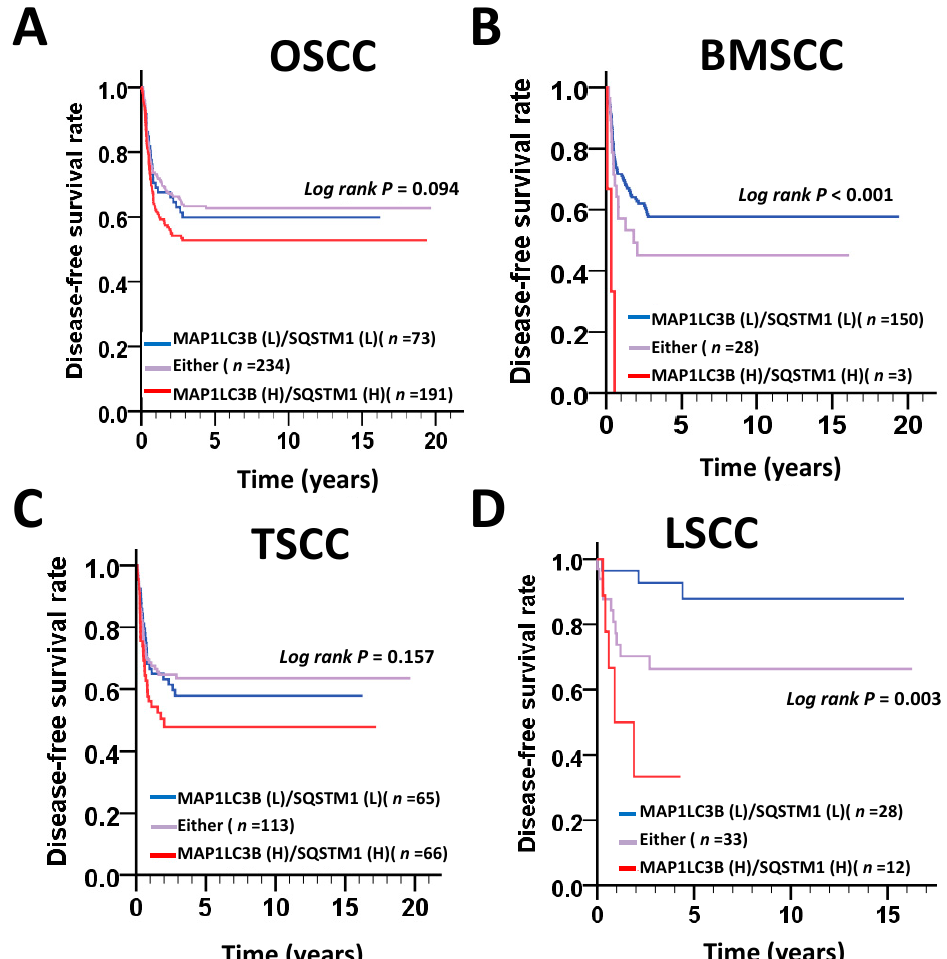
Figure 5. DFS survival curves for the coexpression of MAP1LC3B and SQSTM1 in patients with different subsites of OSCC. DFS survival curves for the coexpression of MAP1LC3 and SQSTM1 are shown for OSCC ( A ) and three main subsites, BMSCC ( B ), TSCC ( C ) and LSCC ( D ). The cutoff values for high or low coexpression of MAP1LC3B and SQSTM1 in tumor tissues were based on the receiver operating characteristic (ROC) curve Table 6. The expression levels of MAP1LC3B and SQSTM1 in disease-free survival of oral SCC patients .